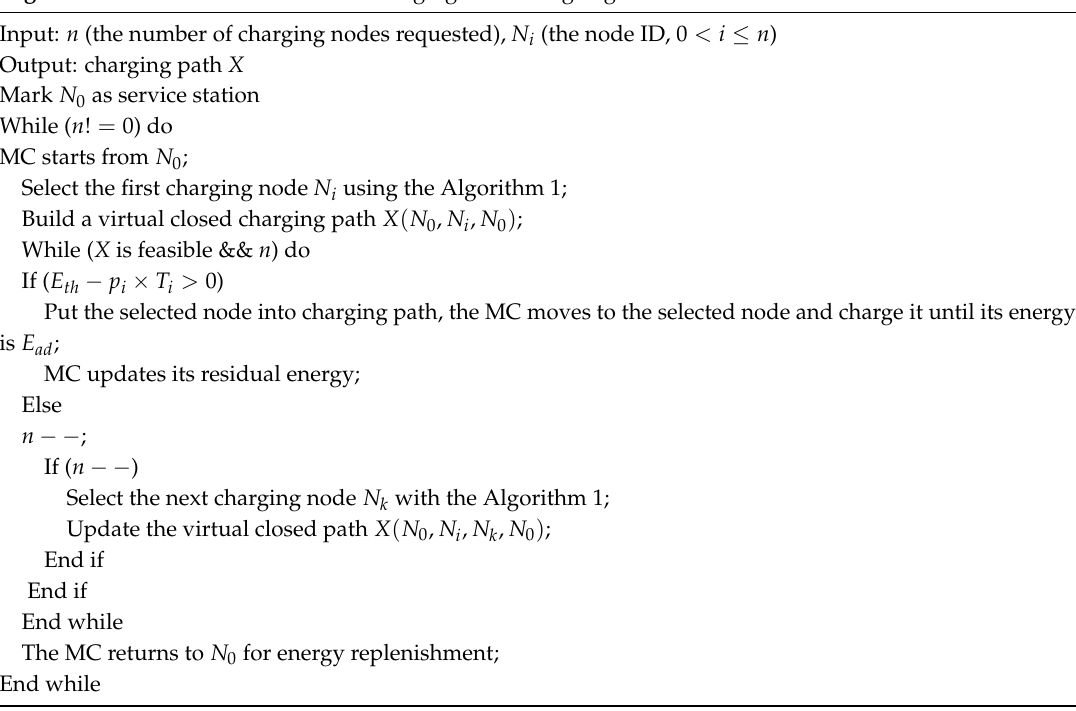
Algorithm 2 Real-Time On-Demand Charging Scheduling